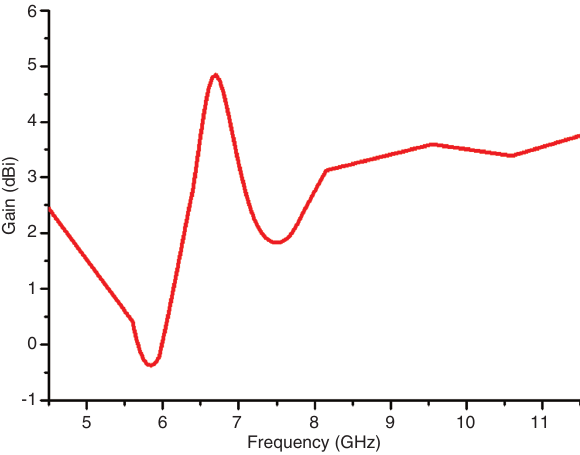
Figure 6 Achieved gain of the proposed antenna.